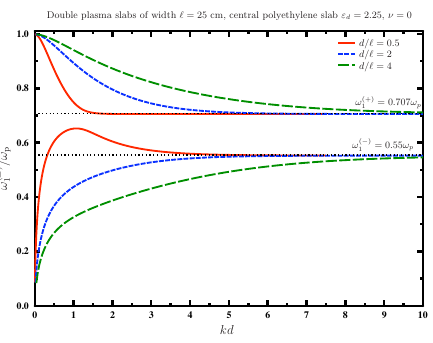
Figure 3: Dispersion curves of two identical plasma slabs with Polyethylene as a central region.